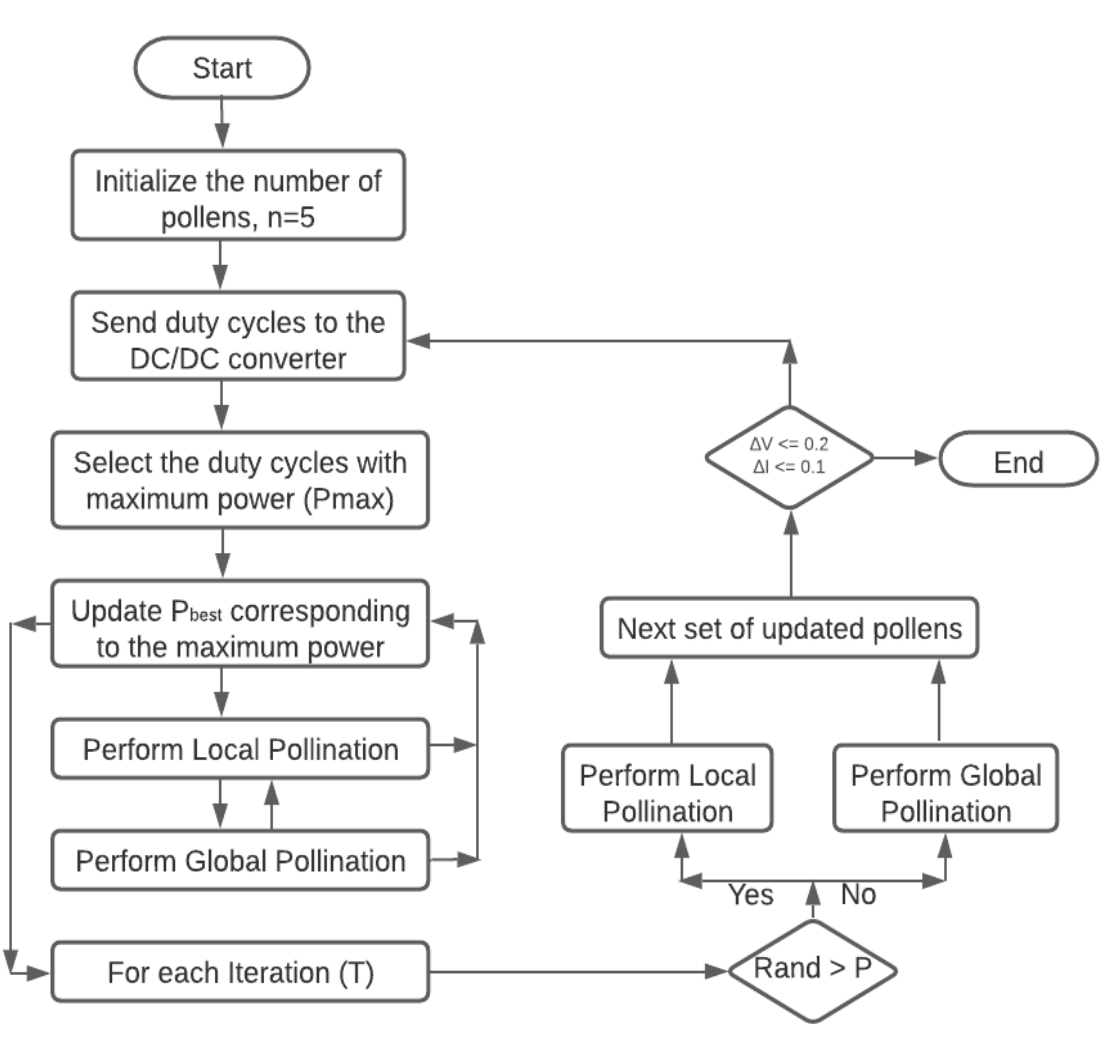
Fig. 4. Modified flower pollination